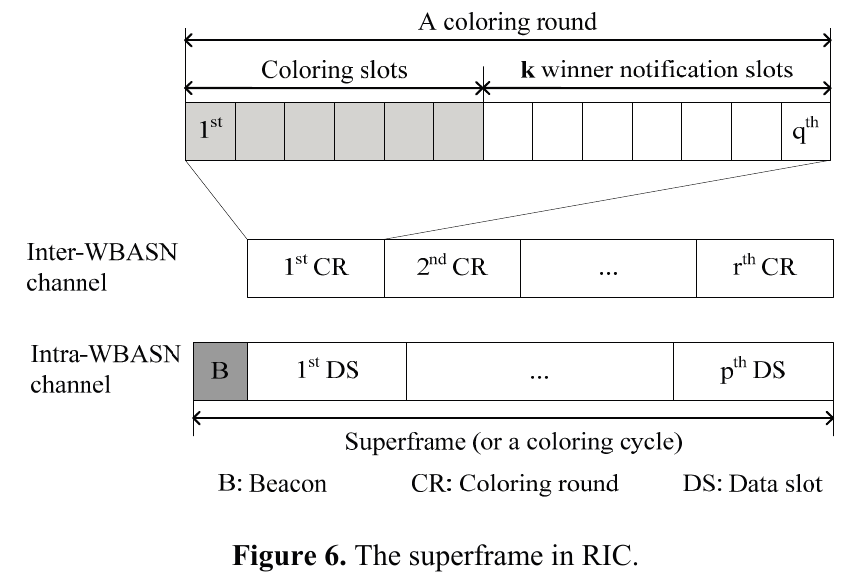
Figure 6. The superframe in